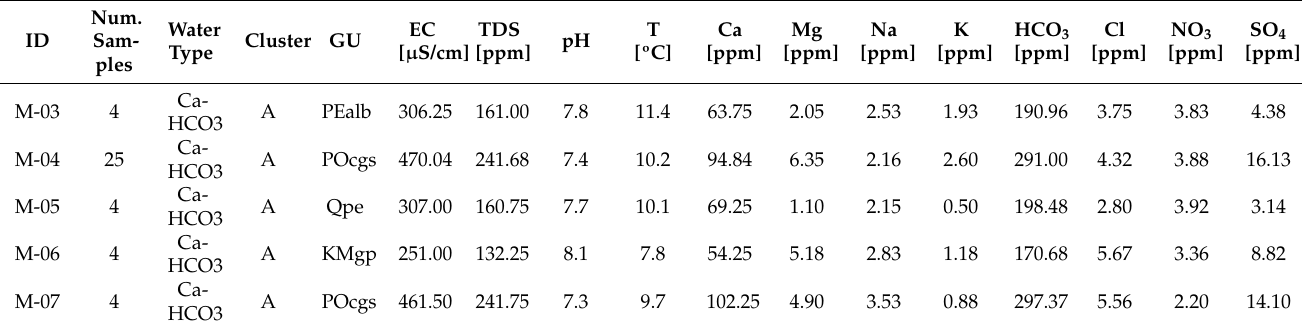
Table A2. Chemical characteristics of major constituents for the 43 water springs (median values for the whole campaigns carried out from September 2013–October